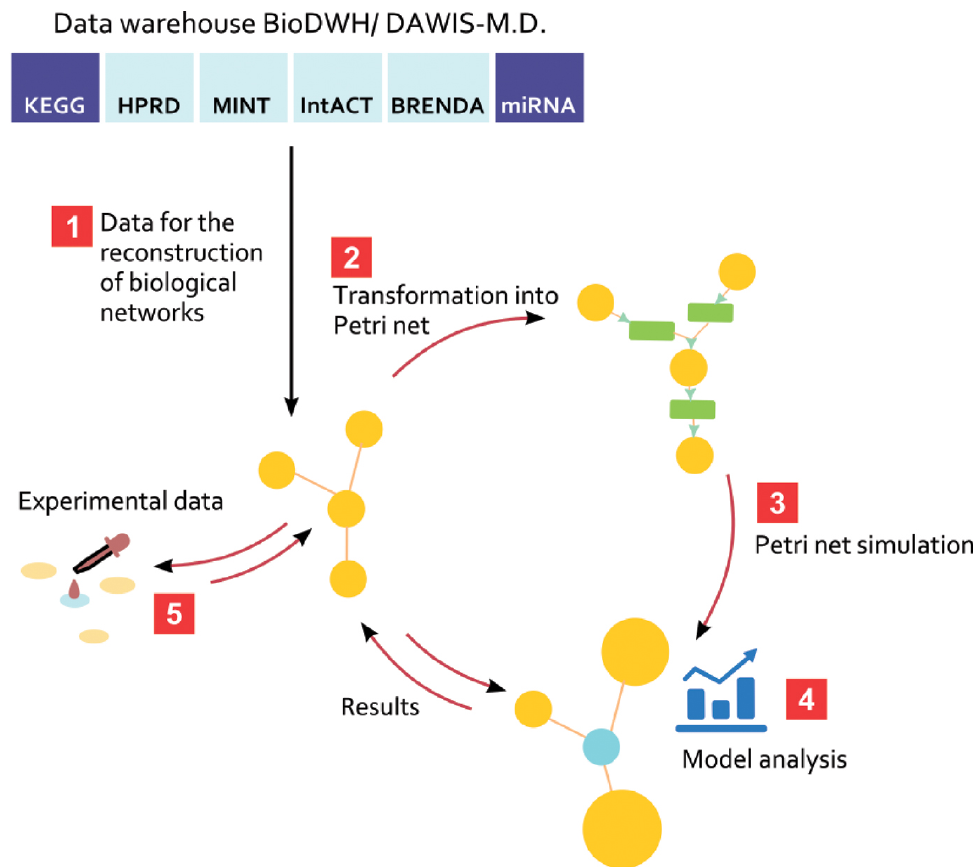
Figure 2: Workflow of VANESA. The highlighted databases KEGG and miRNA were updated or added, respectively. The addition of our custom miRNA database to DAWIS-M.D. enables the analysis and visualization of